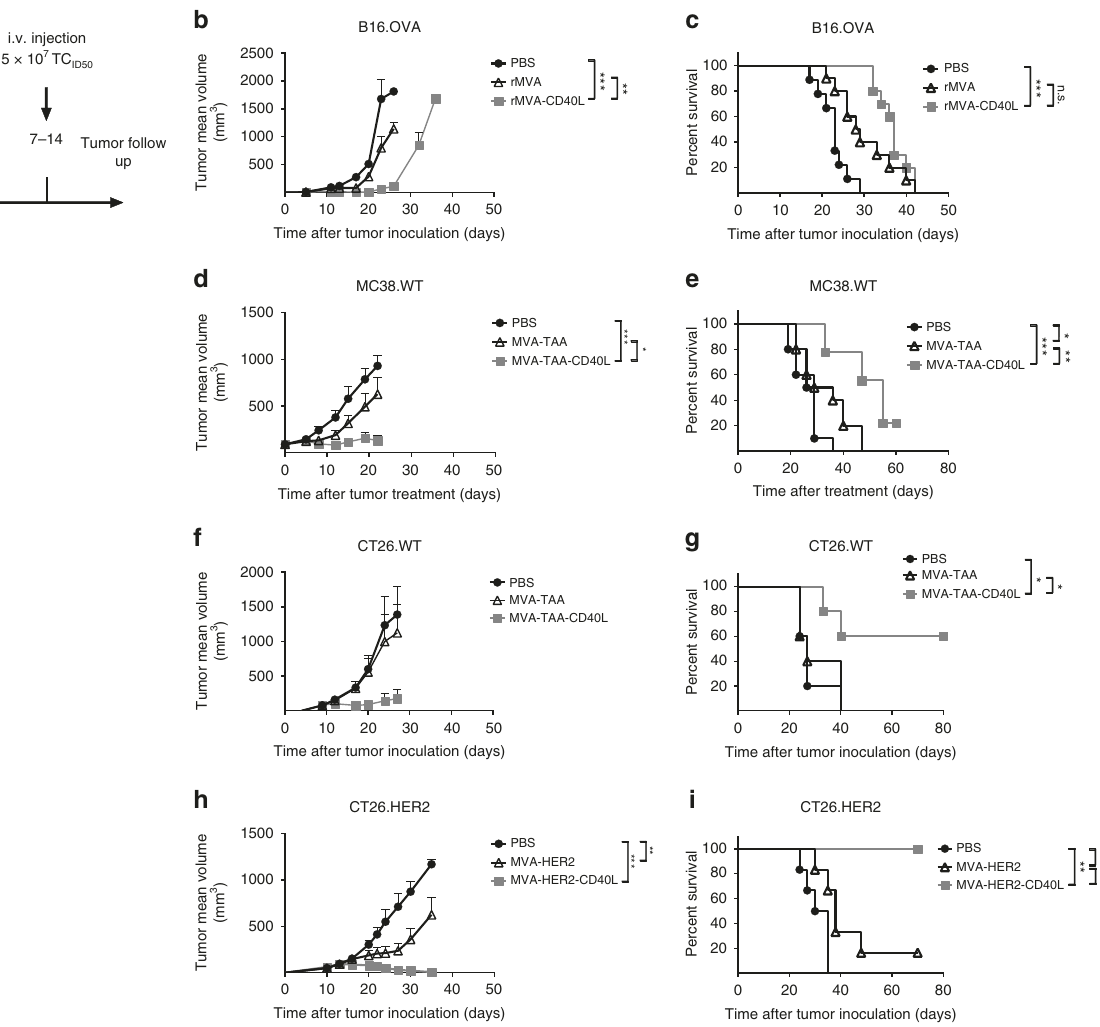
Fig. 1 Therapeutic ef fi cacy of rMVA-CD40L in unrelated, large, established tumor models. a Experimental layout: brie fl y, C57BL/6 ( b – e ) or Balb/c mice ( f – i ) received either B16.OVA ( b , c ), MC38.WT ( d , e ), CT26.WT ( f , g ) or CT26.HER2 ( h , i ) cells subcutaneously in the fl ank. Seven to 14 days later,